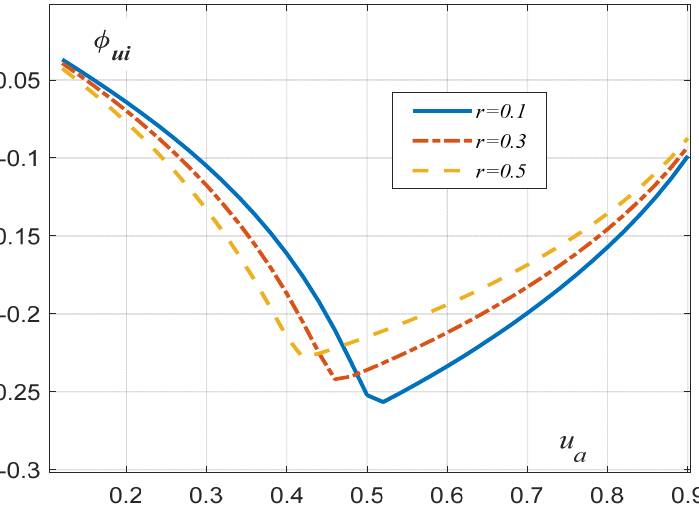
Figure 9. The phase shift angle of the first harmonics of the circuit current with respect to the load voltage as a function of the load voltage amplitude and resistance.